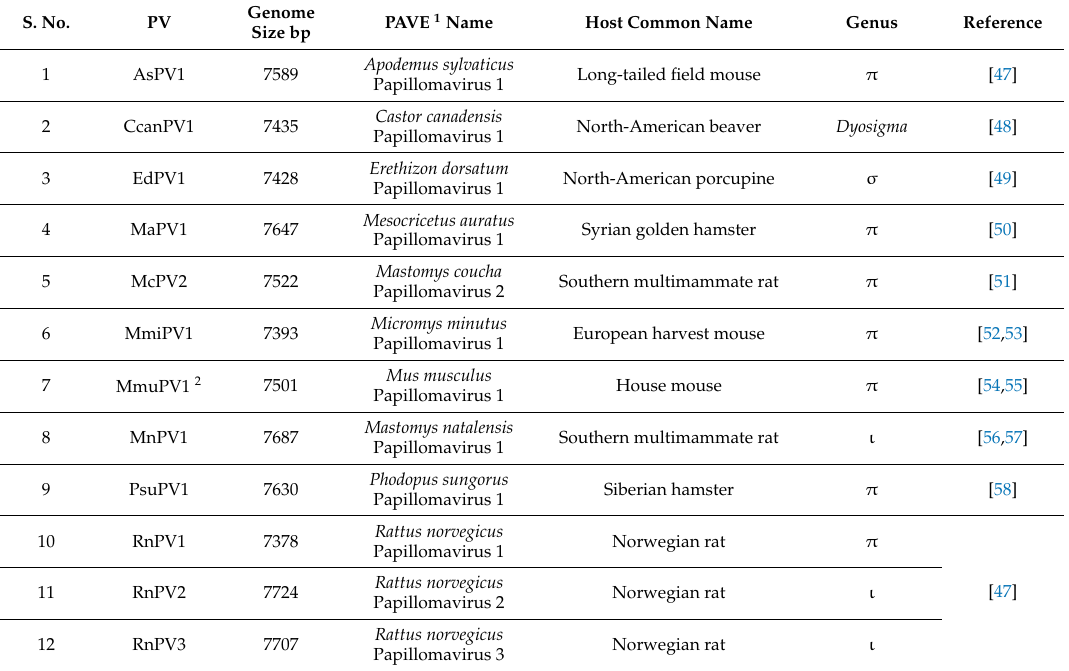
Table 1. List of Rodent